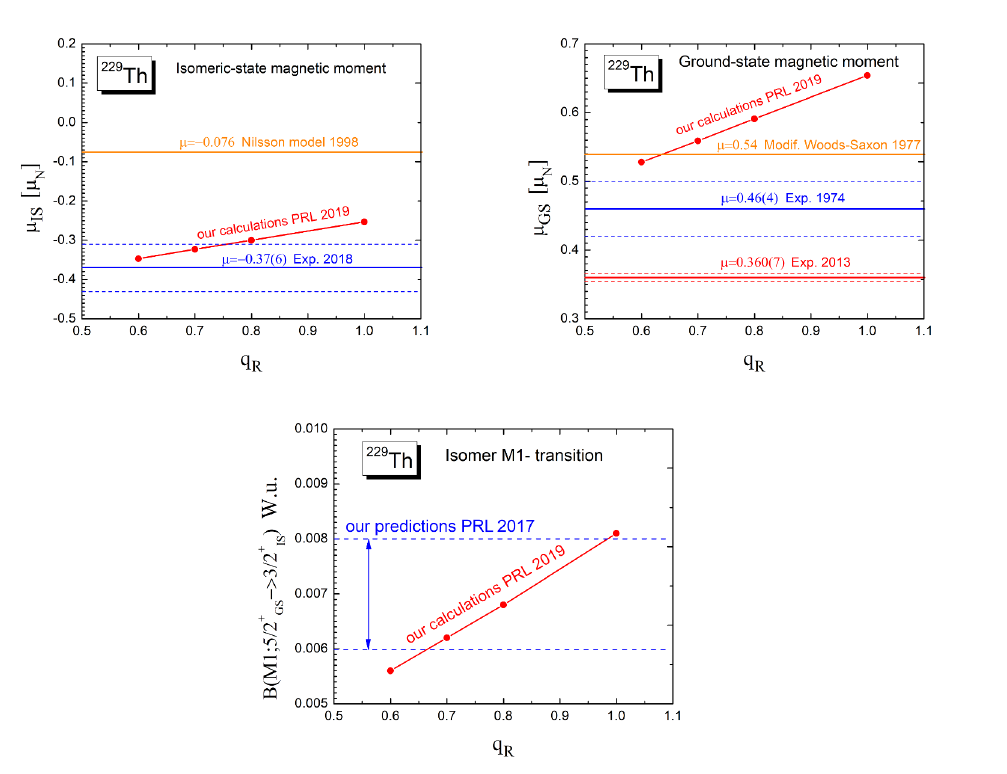
Figure 1. The calculated IS and GS magnetic moments and the isomer B(M1) decay rate in dependence on the quenching factor q R . The dashed lines mark the experimental error bars for the magnetic moments and theoretical-prediction limits for B(M1). See the text for explanations.